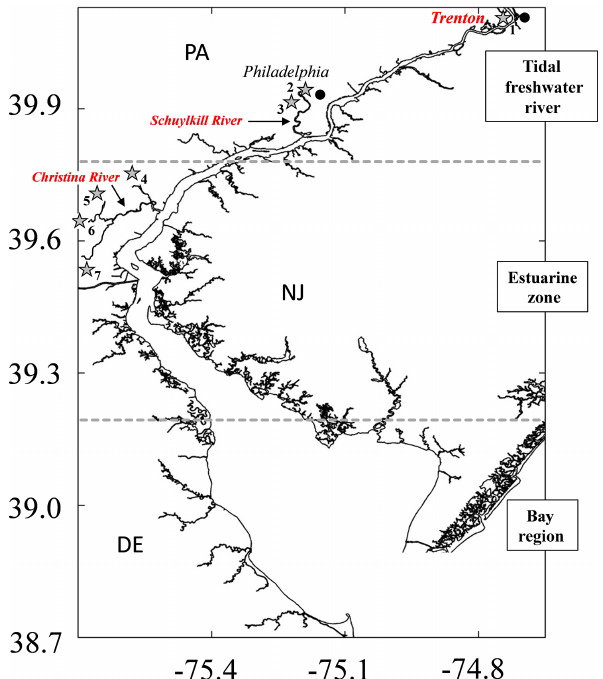
Figure 1. Map of the Delaware Estuary and river tributaries. Gray stars indicate USGS gauging stations (1) 01463500, (2) 01474010,